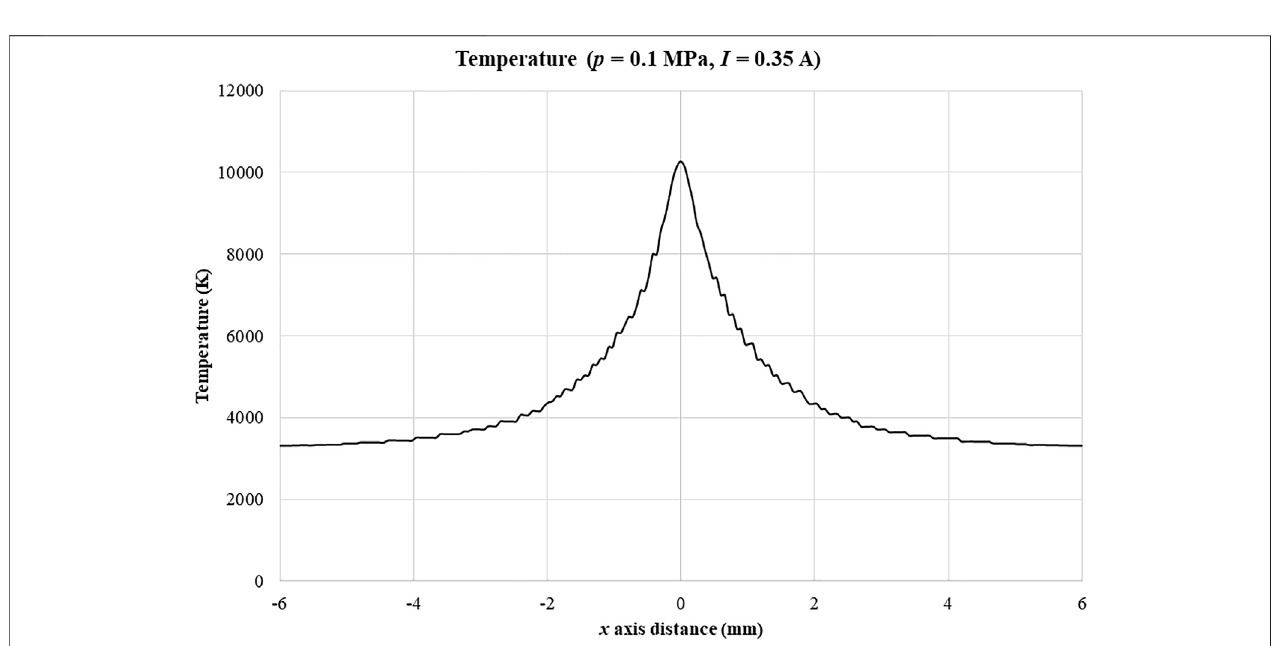
The velocity magnitude in the x axis direction at the center of the inter-electrode gap for the atmospheric pressure discharge for varying electric current is given in Figure 15 .